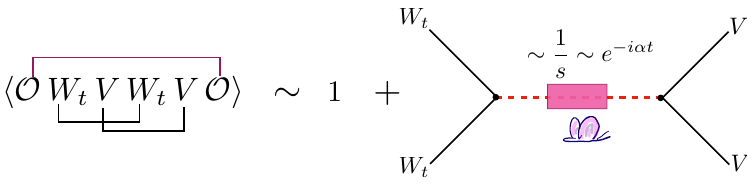
Figure 1: Application of our main result (4) to the butterfly effect (‘scrambling’) in heavy states, i.e. an out-of-time-order “HHLLLL” correlation function. As indicated in purple, the effect of the heavy insertions can be interpreted as dressing the prop- agator, s − 1 , of the leading mode, the “scramblon” [ 26 ] , exchanged between the light operators on the second sheet by the exponential factor s − 1 = e − i α t . In the ergodic phase, α = i | α | , this leads to maximal scrambling, while in the non-ergodic phase, α = | α | , this results in an oscillatory OTOC. The bulk interpretation of the scramblon picture is a single graviton exchange in the heavy background. Full details of the calculation summarized here can be found in section 4